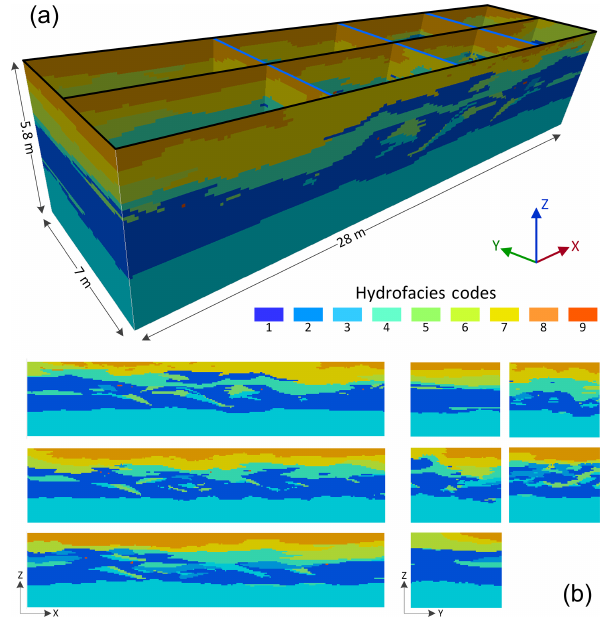
Figure 15. Descalvado aquifer analog dataset (Bayer et al., 2015). (a) 3-D presentation of the informed cross sections: three sections in xz direction, and five sections in yz direction; (b) 2-D presentation of these informed